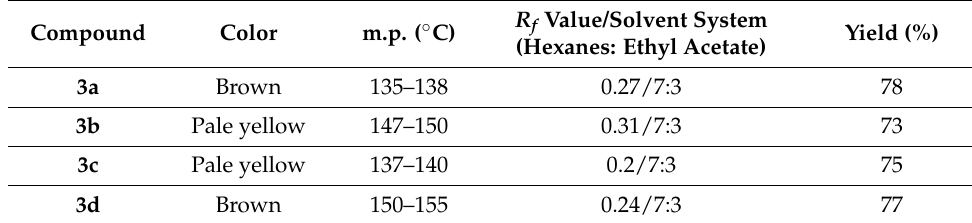
Table 4. Physical data of compounds 3a–d